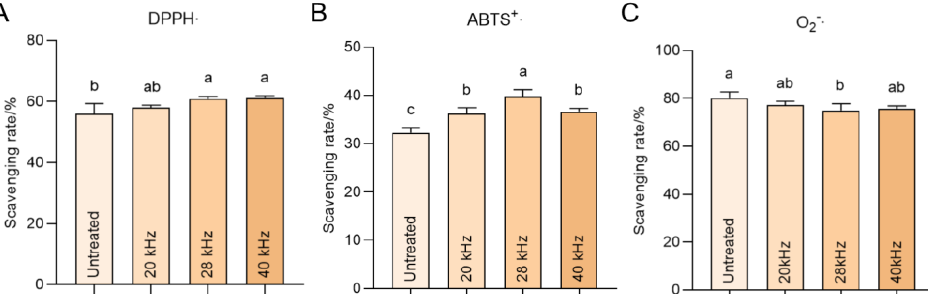
Figure 6. Antioxidative capacity of Sanhua plum wine under different ultrasonic treatment in vitro. The scavenging rates of DPPH · ( A ), ABTS + · ( B ), and O 2 − · ( C ) were in vitro tested in Sanhua plum wine after three-month aging. Different letters indicate a significant difference between the groups.